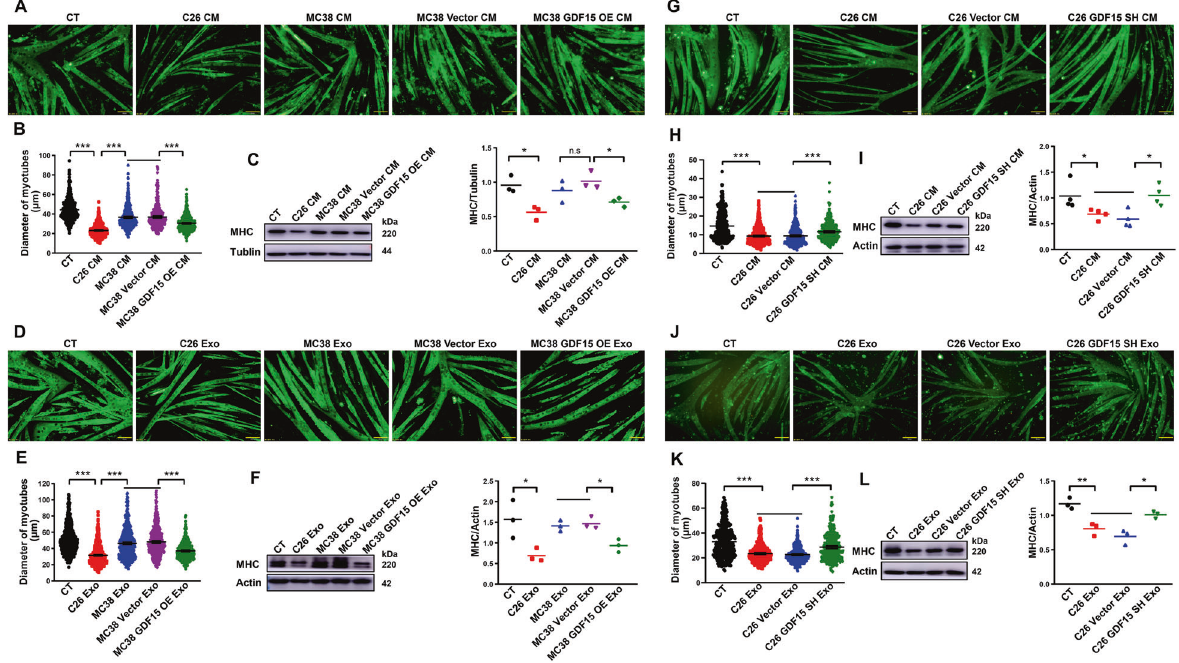
Fig. 6 Contribution of GDF15 in the potency of tumor cells and tumor exosomes in inducing muscle atrophy. C2C12 myotubes were treated with MC38-GDF15-OE cell medium, exosomes or C26-GDF15-SH cell medium, exosomes respectively. A Representative immuno fl uorescent images of C2C12 myotubes treated with MC38-GDF15-OE cell culture medium (scale bars, 50 μ m). B Quanti fi cation analysis of C2C12 myotubes diameter ( n = 546,524,508,401,540, *** p < 0.001; t test). C MHC protein expression analysis via western blot ( n = 3, ns p > 0.05, * p < 0.05; t test). D Representative immuno fl uorescent images of C2C12 myotubes treated with MC38-GDF15-OE cell exosomes (scale bars, 50 μ m). E Quanti fi cation analysis of C2C12 myotubes diameter ( n = 662,960,544,507,507, *** p < 0.001; t test). F MHC protein expression analysis via western blot ( n = 3, * p < 0.05; t test). G Representative immuno fl uorescent images of C2C12 myotubes treated with C26-GDF15-SH cell culture medium (scale bars, 50 μ m). H Quanti fi cation analysis of C2C12 myotubes diameter ( n = 564,539,472,445, *** p < 0.001; t test). I MHC protein expression analysis via western blot ( n = 4, * p < 0.05; t test). J Representative immuno fl uorescent images of C2C12 myotubes treated with C26-GDF15-SH cell exosomes (scale bars, 50 μ m). K Quanti fi cation analysis of C2C12 myotubes diameter ( n = 361,359,361,367, *** p < 0.001; t test). L MHC protein